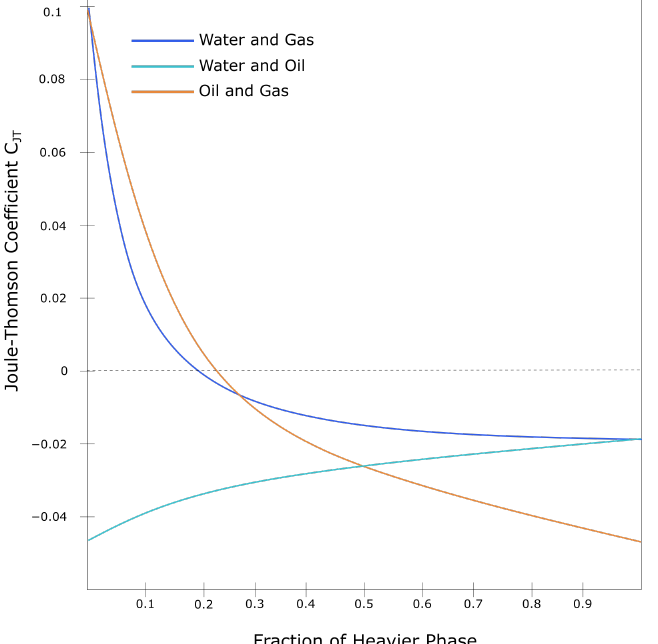
Figure 9. The relation between Joule-Thomson coefficient and fraction of fluid mixture. Adapted from ref.